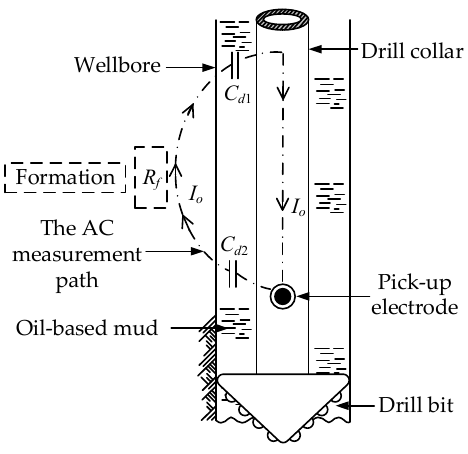
Figure 3. Diagram of the application of the C 4 D technique in LWD.